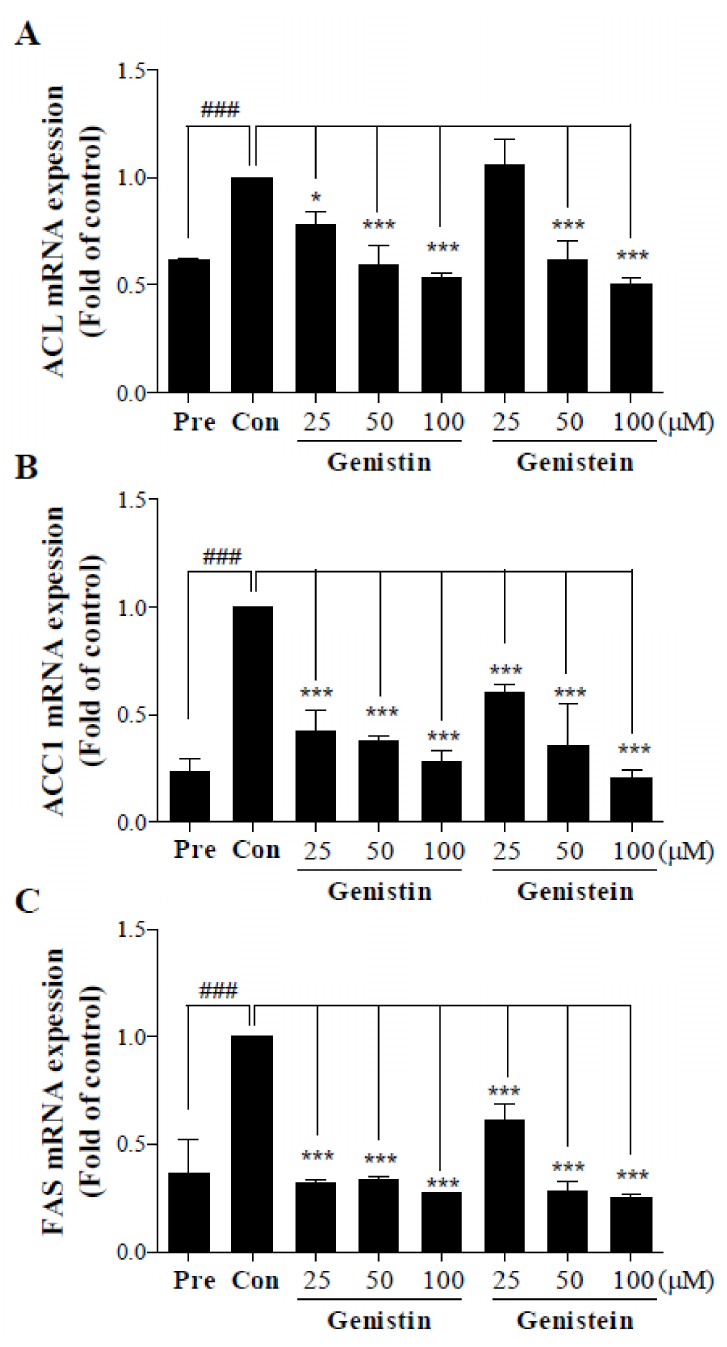
Figure 4. Effect of genistin and genistein on mRNA levels of lipogenic-related factors in 3T3-L1 adipocytes. 3T3-L1 cells were completely differentiated in the MDI media in the presence of 25, 50, or 100 µ M genistin or genistein during the differentiation process. The mRNA expression of lipogenic factors, including ( A ) ACL, ( B ) ACC1, and ( C ) FAS was evaluated. All data were expressed as fold changes in expression relative to that in the control, untreated adipocytes ( n ≥ 3, ### p < 0.001 vs. Pre (preadipocyte) group; * p < 0.05, *** p < 0.001 vs. Con (control, adipocyte) group; one-way ANOVA with the Tukey’s post-hoc test). ACL, ATP citrate lyase; ACC1, acetyl-CoA carboxylase 1; FAS, fatty acid